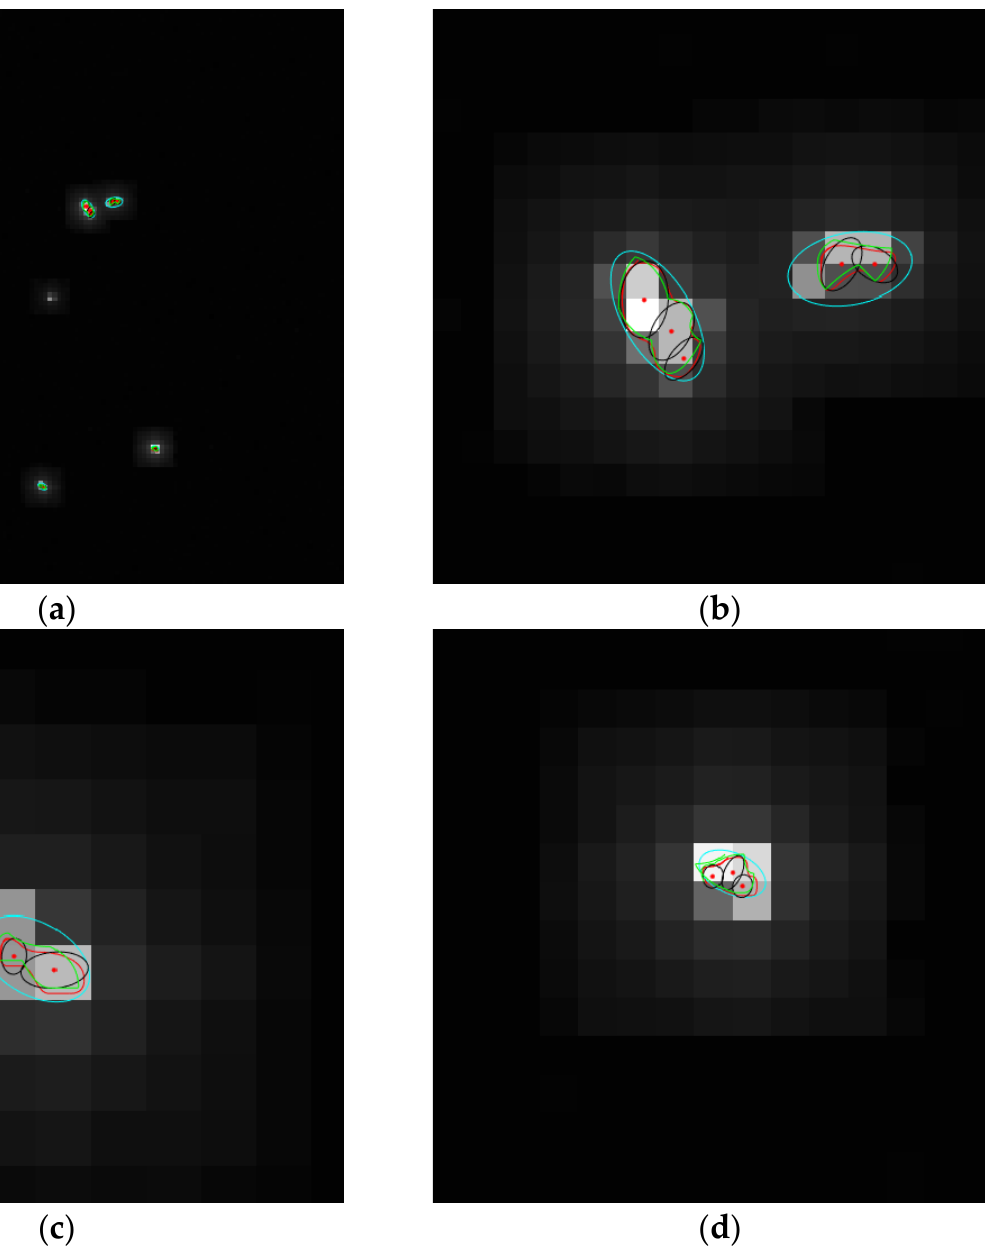
Figure 9. The extension estimation of extended targets under different algorithms for frame 36. ( a ) estimation of extension; ( b ) enlarged image of target 1 and target 2; ( c ) enlarged image of target 3; ( d ) enlarged image of target 4.